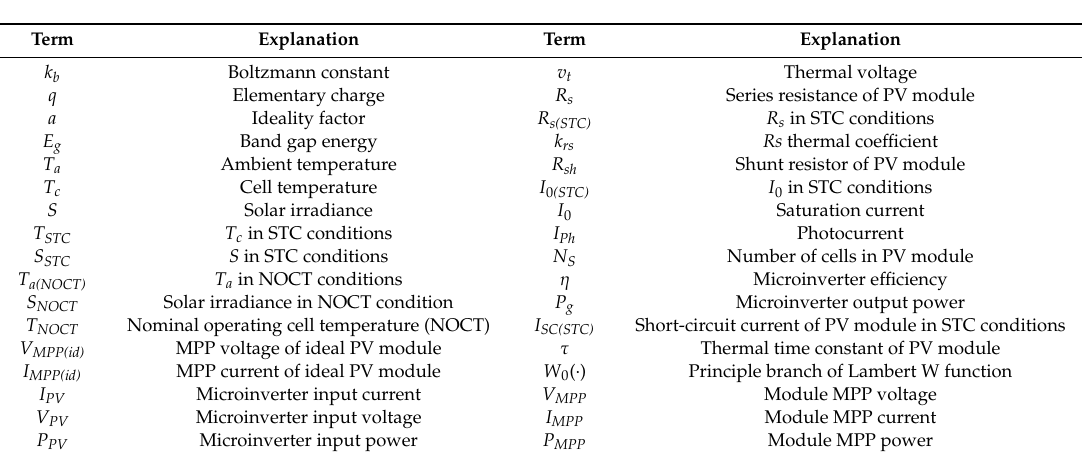
Table 3. PV module parameters.